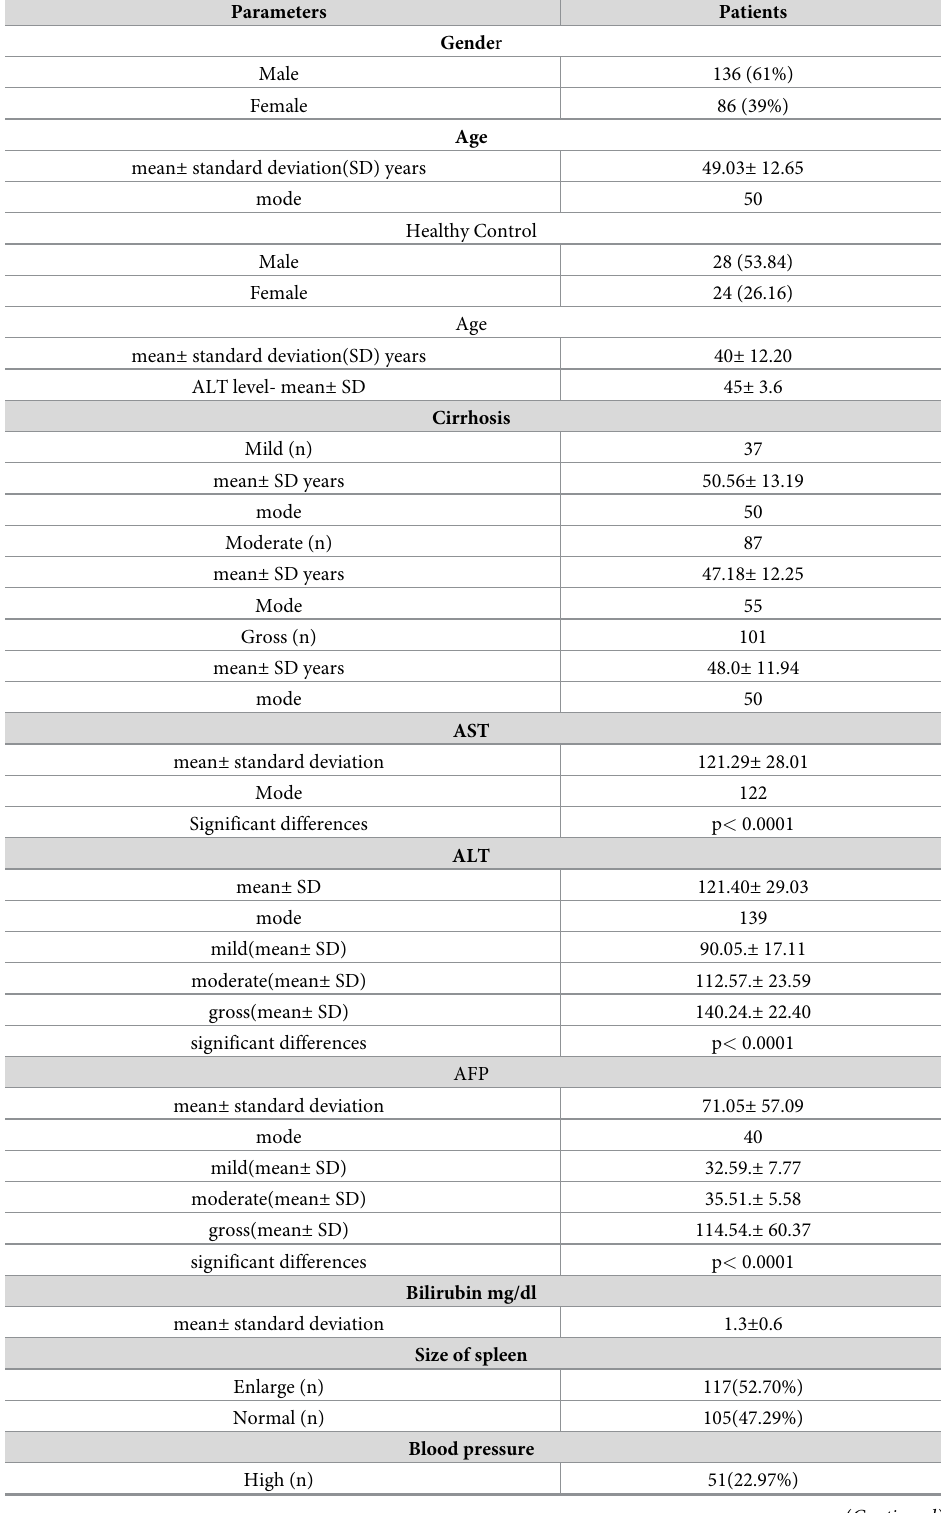
Table 1. Demographic characteristics of 222 HCV cohort and 52 healthy